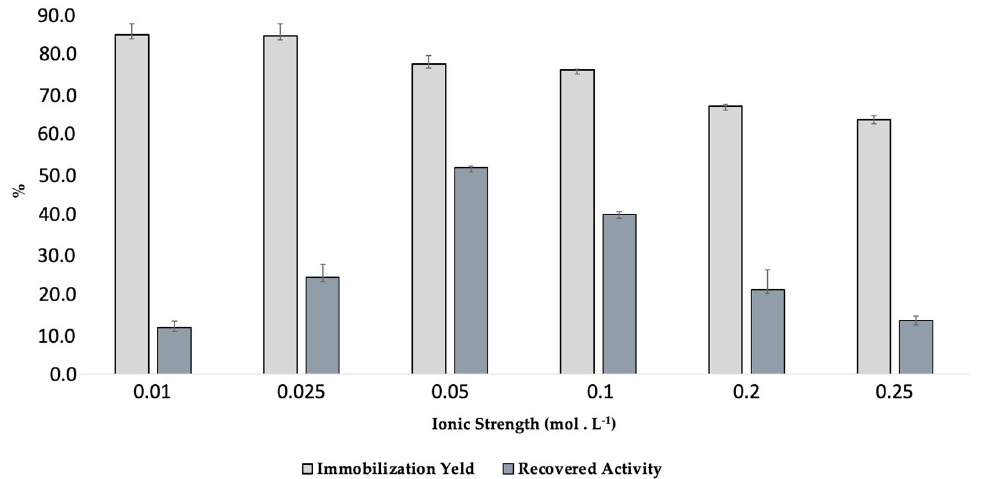
Figure 4. Effect of ionic strength on immobilization yield and recovery activity at immobilization of L Asp on CC support. Experimental conditions: 0.150 g of CC, 5 mL of laccase solution (0.1 g.mL − 1 ) in sodium phosphate buffer solution with pH 7.0 (ionic strength in concentration between 0.01–0.25 mol.L − 1 ), and 4 °C at 100 rpm under shaker.